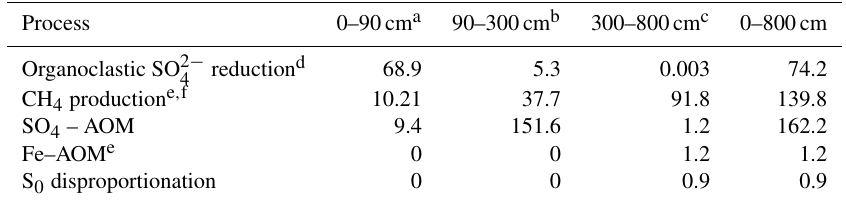
Table 6. Depth-integrated rates of key processes for selected depth intervals in µmolm − 2 d − 1